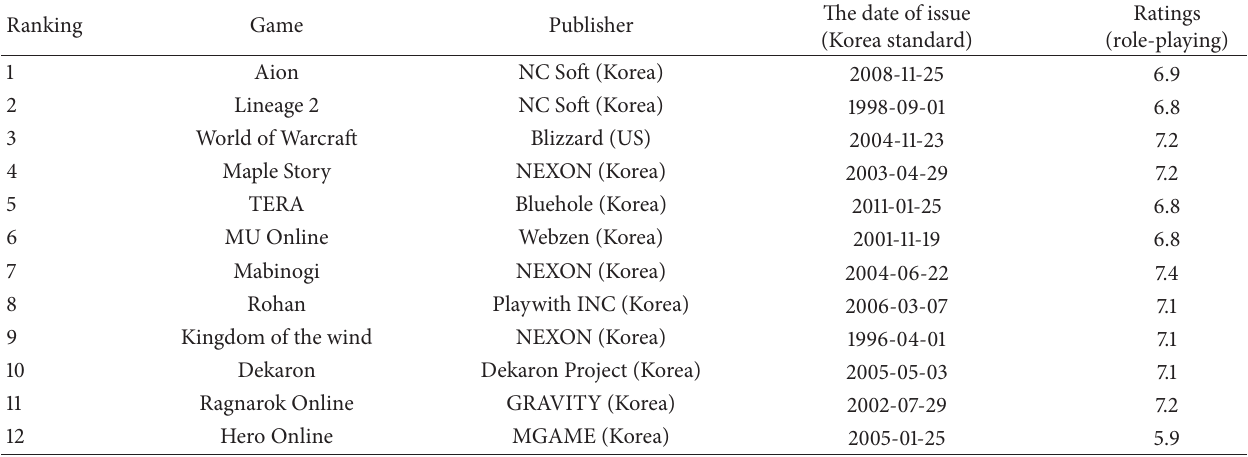
Table 1: Descriptive information.